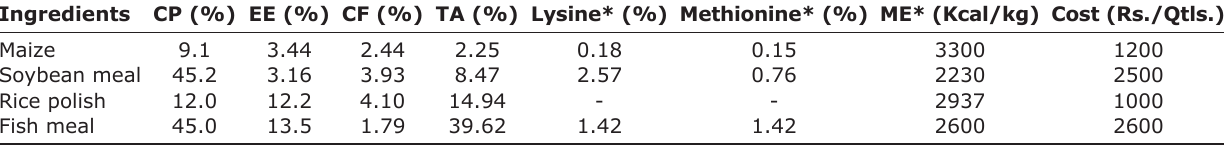
Table-1: Chemical composition of feed